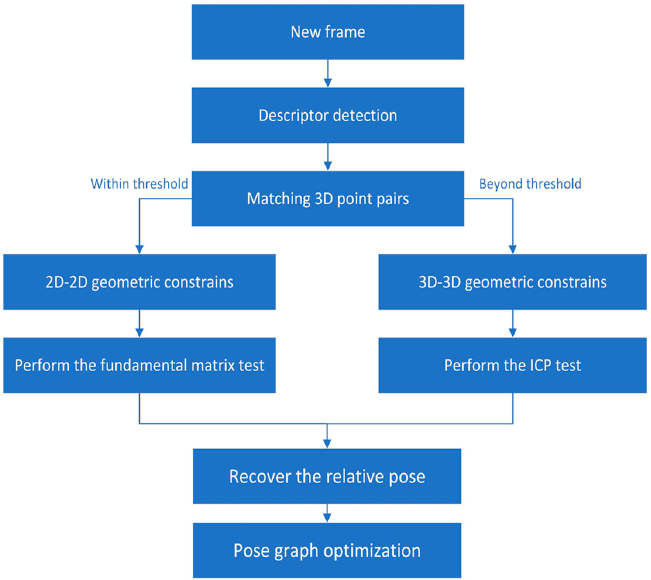
Figure 7. Loop Closure strategy of our system.